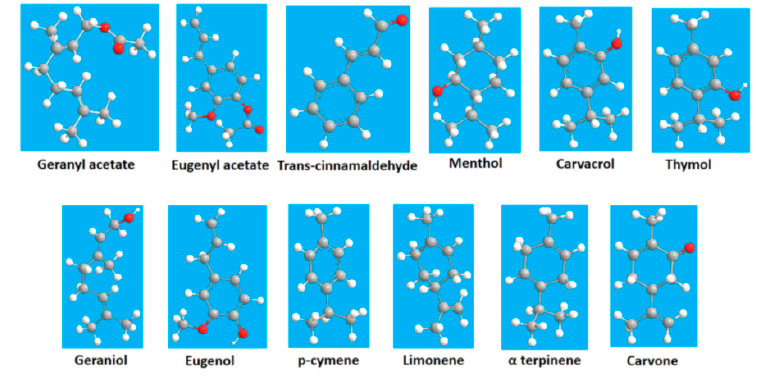
Figure 1. Main chemical components of Eos [40].